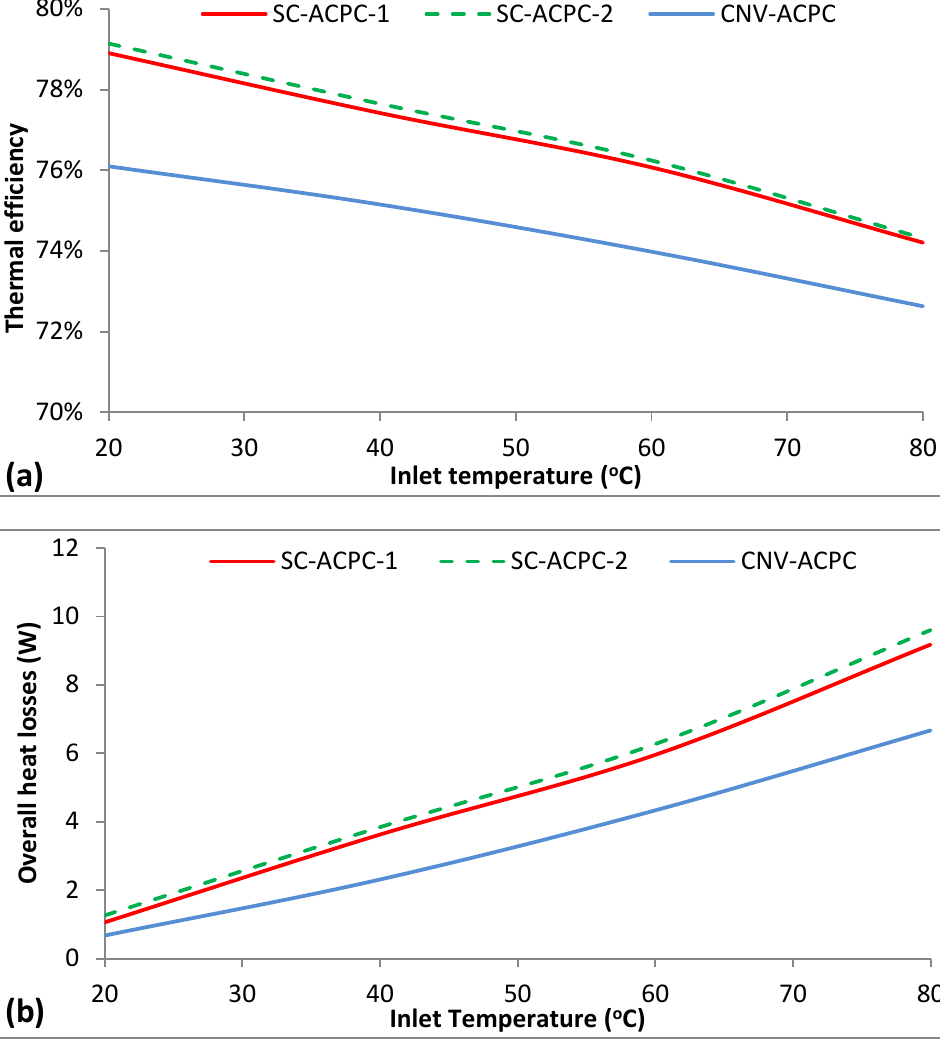
Figure 9. Thermal operation of the model ( a ) Thermal performance and ( b ) Thermal losses.